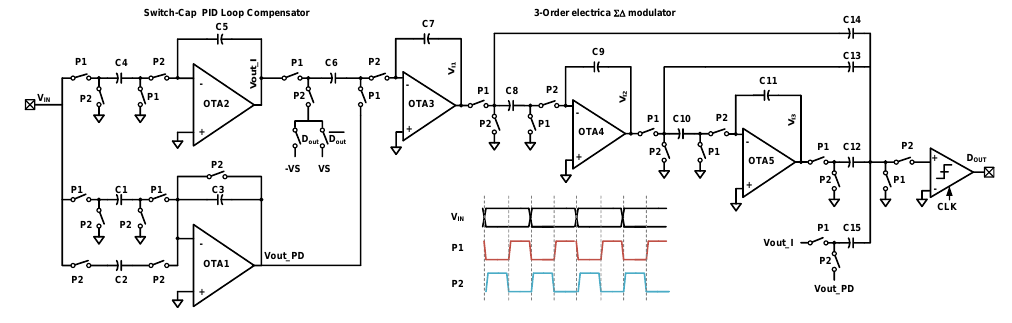
Figure 13. The signal flow diagram of the quantization noise